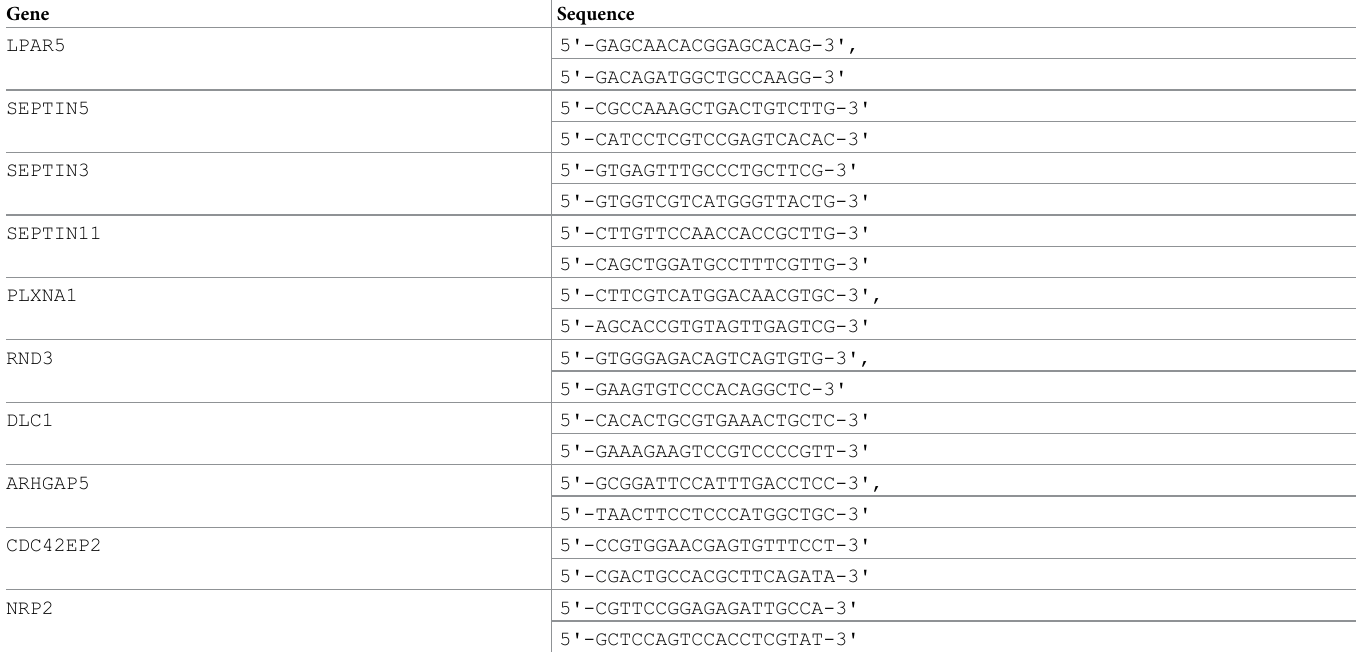
Plus (Diagenode) and centrifuged at 12,000 g for 10 min at 4˚C. The cell pellet was discarded. Protein concentration of the supernatant was measured by DC Protein Assay Kit II (BioRad) at absorbance 750nm using a microplate reader (BioTek). The sample lysates were resolved in SDS-PAGE and transferred onto a PVDF membrane (BioRad). The membrane was blocked with 5% non-fat milk in PBST for 1 hr and incubated with a primary antibody, followed by an HRP-conjugated secondary antibody (Table 2). Specific bands were visualized using WEST- SAVE Up (AbFrontier).